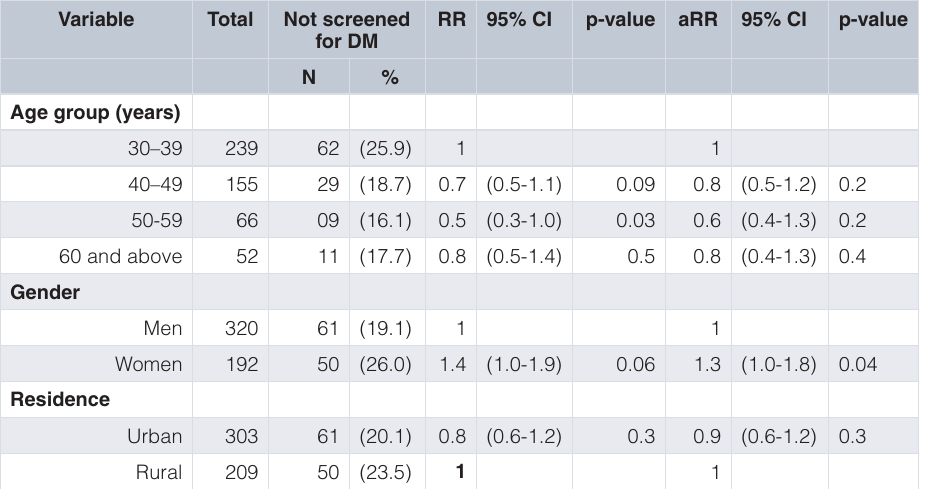
Table 3. Association of socio-demographic characteristics with not being screened for diabetes mellitus (DM) among persons aged ≥ 30 years seeking care at the outpatient department in the two selected primary healthcare centres from March to May, 2019